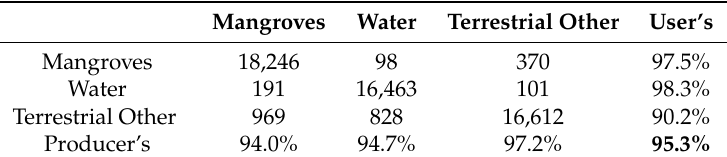
Table 5. Accuracy assessment of the GMW v2.0 baseline.